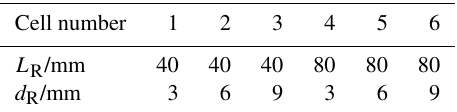
Table 1. Resonance cylinder length L R and resonance cylinder di- ameter d R for the six different T-cells, in